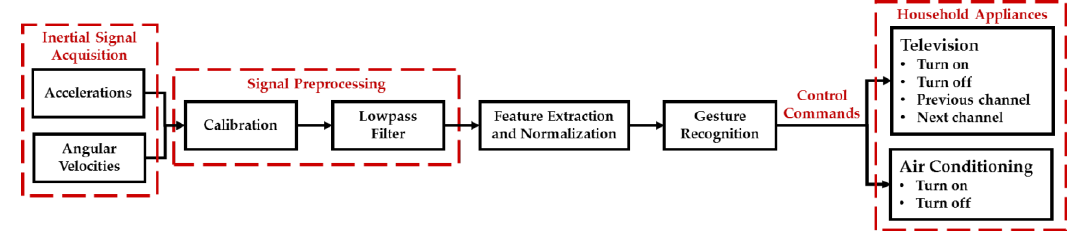
Figure 8. Block diagram of the 3D gesture recognition algorithm.